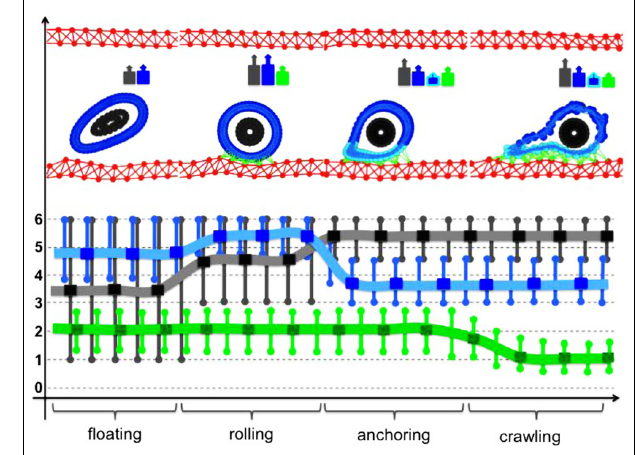
FIGURE 4 | Circulating tumor cell migrating on the endothelium. Four time snapshots (taken at time t, 2t, 5t, and 10t) are overexposed on the same picture for comparison of cell deformation and translocation. (A) The cell cortex is stained differently depending on its local stiffness: soft (cyan) close to cell focal adhesion with EW, and stiff (blue) far from EW contacts. (B) A fixed small part of the cell cortex is stained for illustration of the rolling effect.